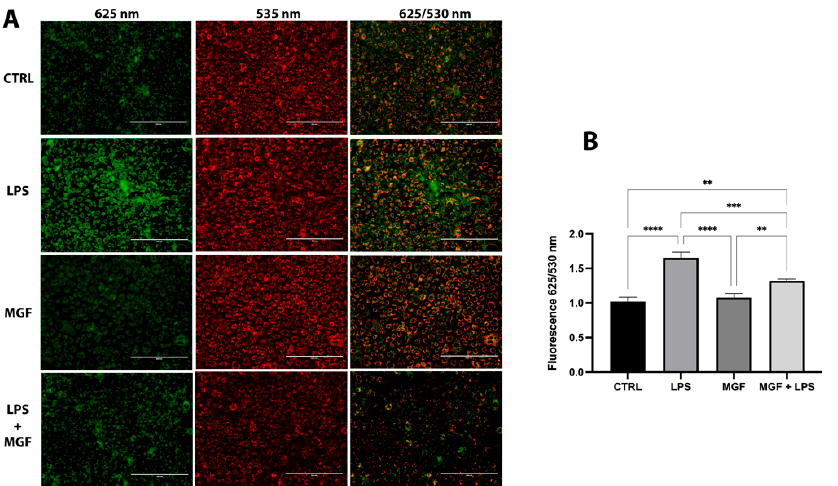
Figure 6. ( A ) Fluorescence images of JC-1 staining after 6 h of treatment; scale bar = 200 μ m. ( B ) Effect of MGF and LPS on mitochondrial membrane potential. Cells were treated with LPS 10 μ g/mL for 1 h, and MGF 20 μ g/mL for 5 h. ** p < 0.01; *** p < 0.001; **** p < 0.0001.